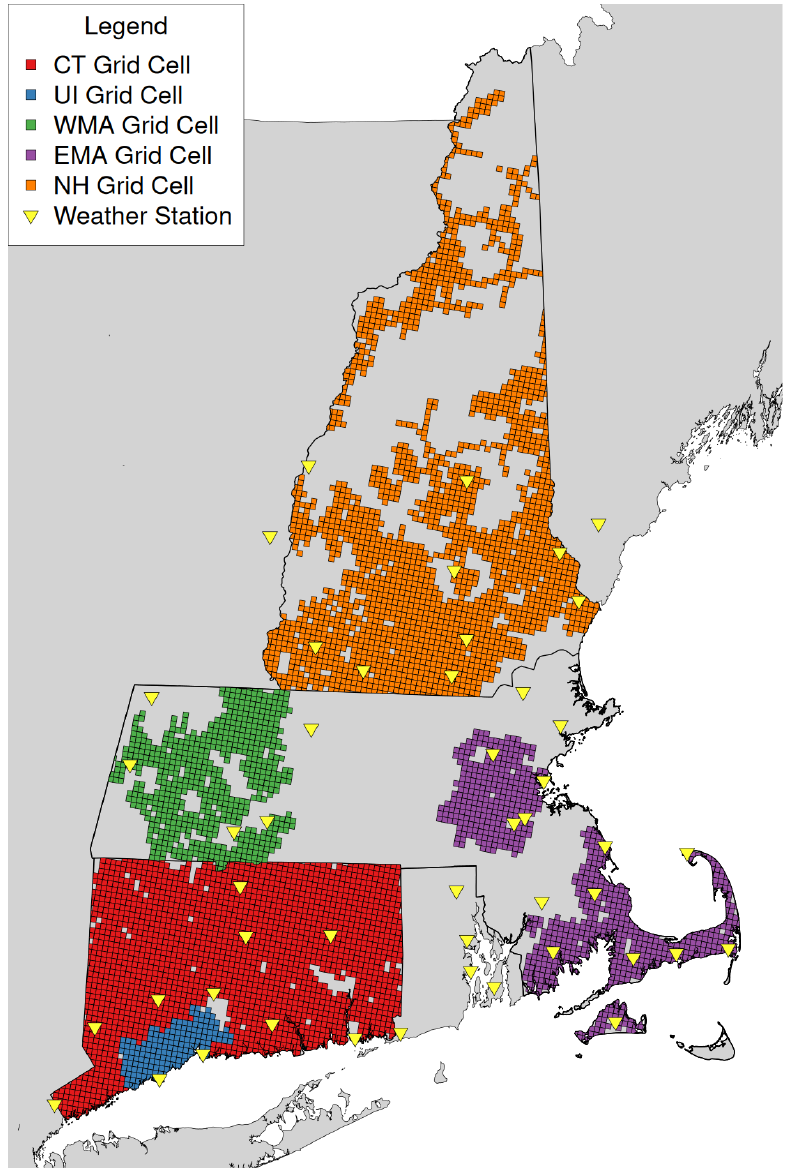
Figure 1. The location of the outage model grid cells by service territory as well as the location of the airport weather stations used in the meteorological